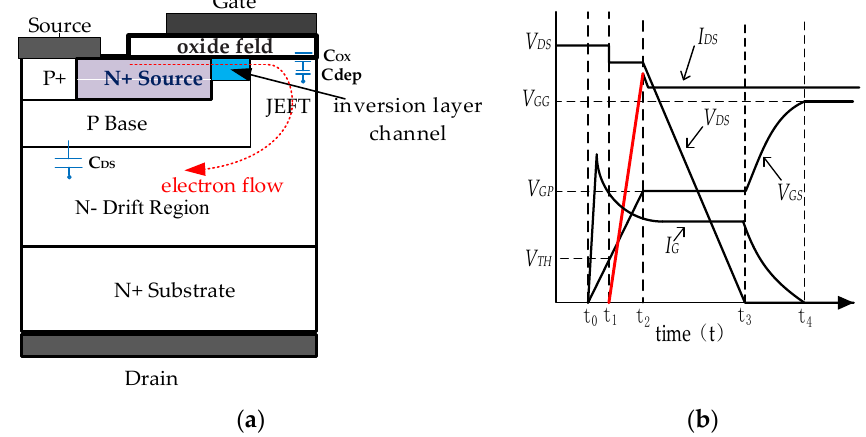
Figure 1. ( a ) Cell Structure of planar silicon carbide (SiC) metal ‐ oxide semiconductor field effect transistor (MOSFET) (N ‐ channel), ( b ) Typical SiC MOSFET turn ‐ on transient waveforms under an inductive load.